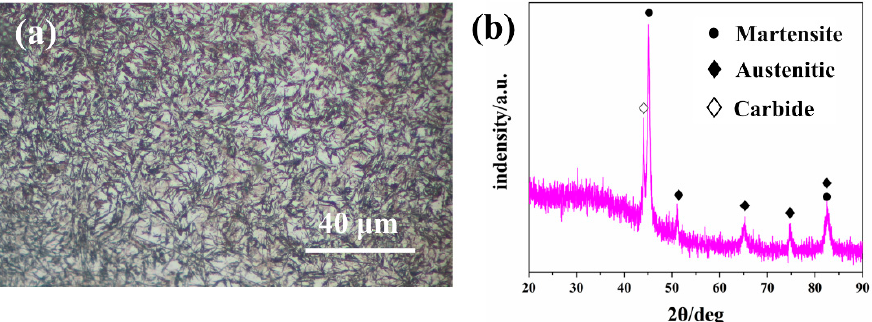
Figure 1. Schematic of ( a ) the metallographic organization and ( b ) the surface XRD analysis of AISI 9310